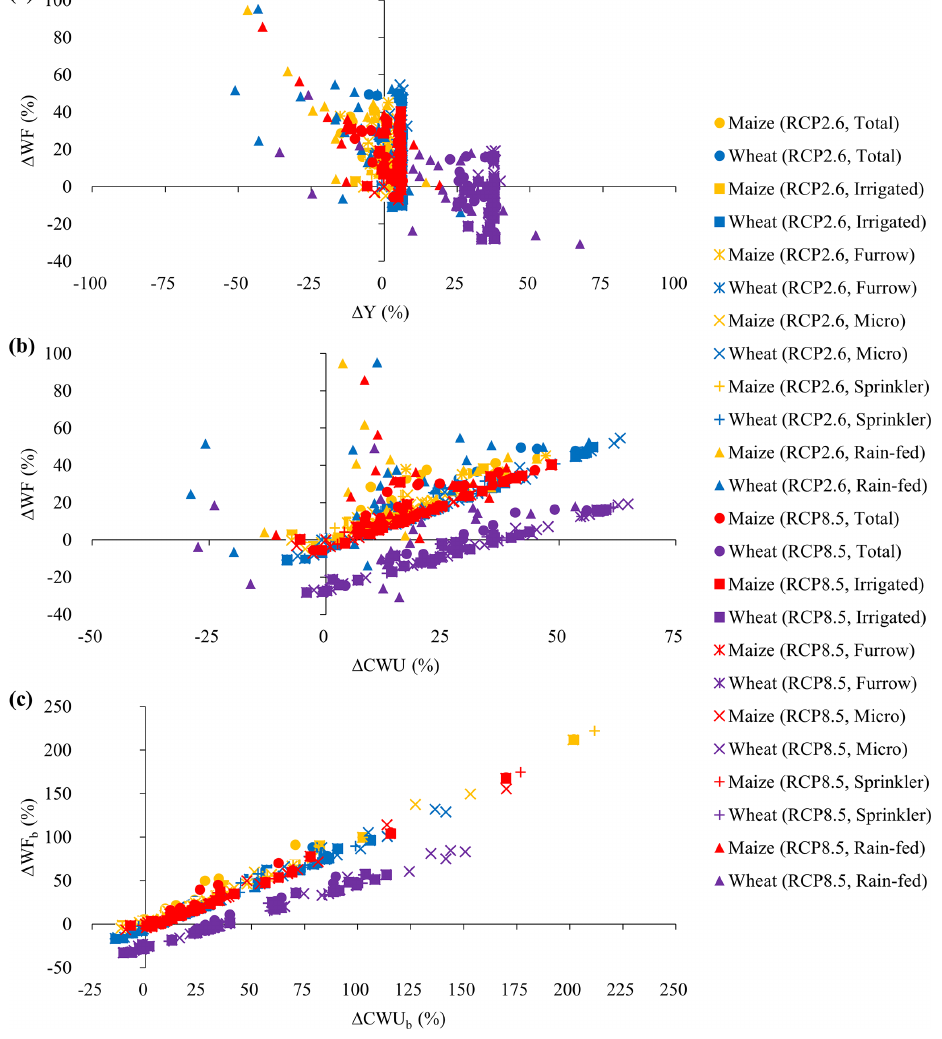
Figure 7. Relationships between relative changes (cid:49) (%) in (a) Y and the corresponding WF, (b) CWU and the corresponding WF, and (c) CWU b and the corresponding WF b of two crops under RCP2.6 and RCP8.5 from 2013 to the